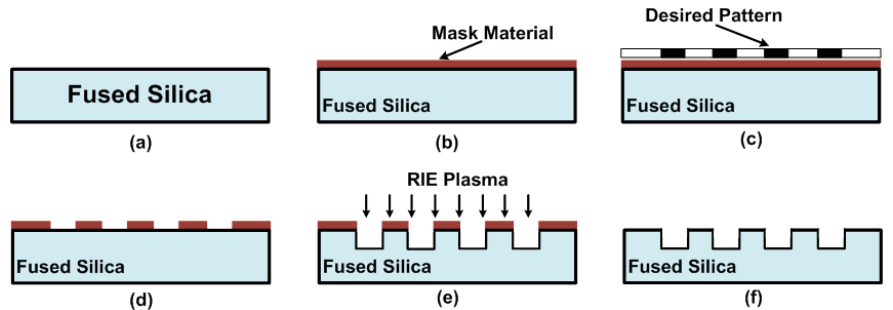
Figure 1. Through via hole fabrication process by deep reactive-ion etching (DRIE): ( a ) Sample cleaning; ( b ) Deposition of mask material; ( c ) Transfer of desired pattern; ( d ) Desired pattern achieved; ( e ) Inductively coupled plasma-reactive ion etching (ICP-RIE) dry etching; ( f ) Removal of mask residual.